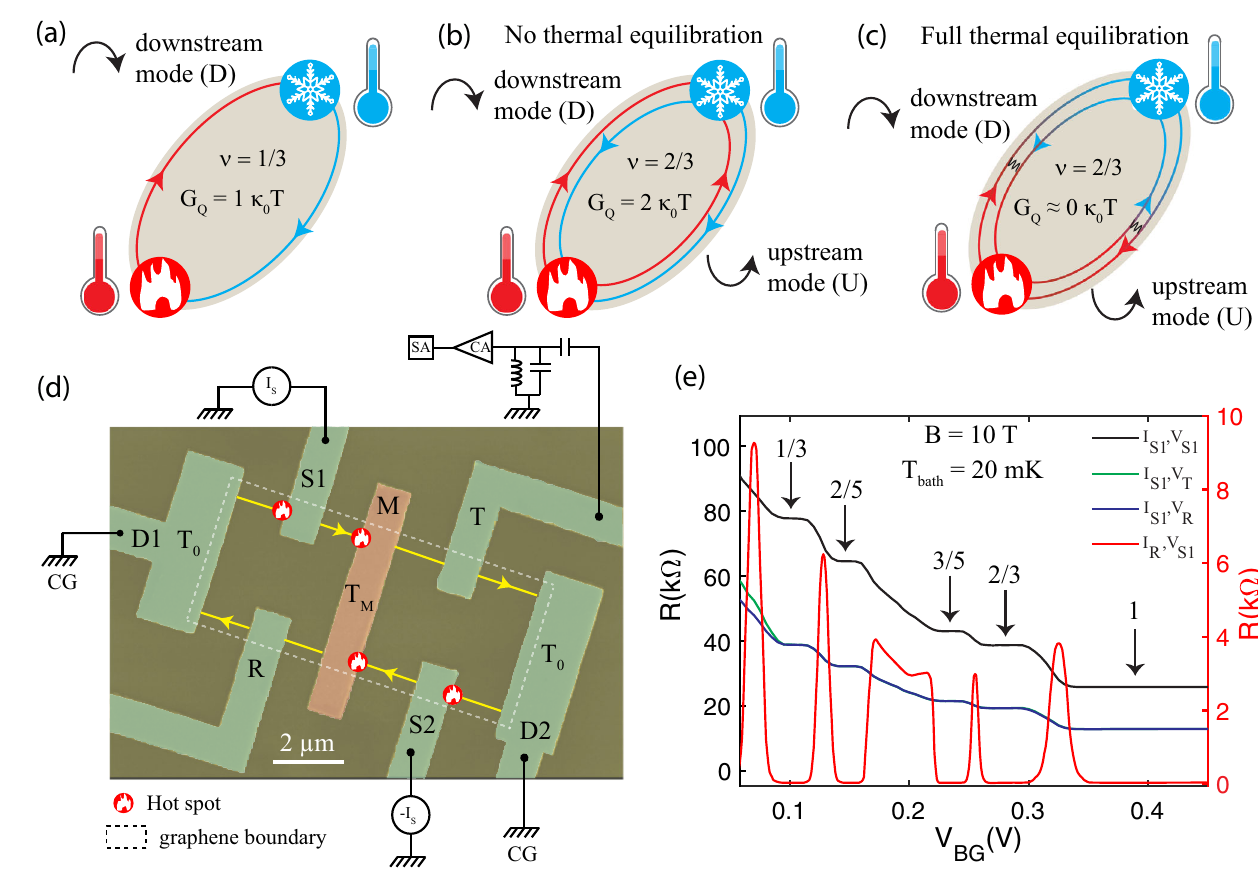
Fig.1|SchematicsofheattransportonQHedges,measurementsetup,andQH response of device. a Heat transport at the edge of ν =1/3 state along a single downstream mode. The chirality of the downstream mode is clockwise. b Heat transport at the edge of ν =2/3 state in nonequilibrated regime. Heat from the hot reservoiriscarriedawaybybothdownstreamandupstreammodes.Thechiralityof upstream mode is anticlockwise. c Heat transport at the edge of ν =2/3 state in the equilibrated regime. The gradient of the color along the edges represents the qualitative temperature pro fi le. In the long-length limit ( L → ∞ ), the heat carried awayfromthehotreservoircomesbacktoitviaotheredgemodes,whichleadstoa vanishing thermal conductance. d False colored SEM micrograph of the device, shownwith the measurement schematic. The graphene boundary ismarked with a white dashedline.For illustrative purposes, the device is depicted with a ν =1 edge structure. For thermal conductance measurements, currents I S and − I S are fed